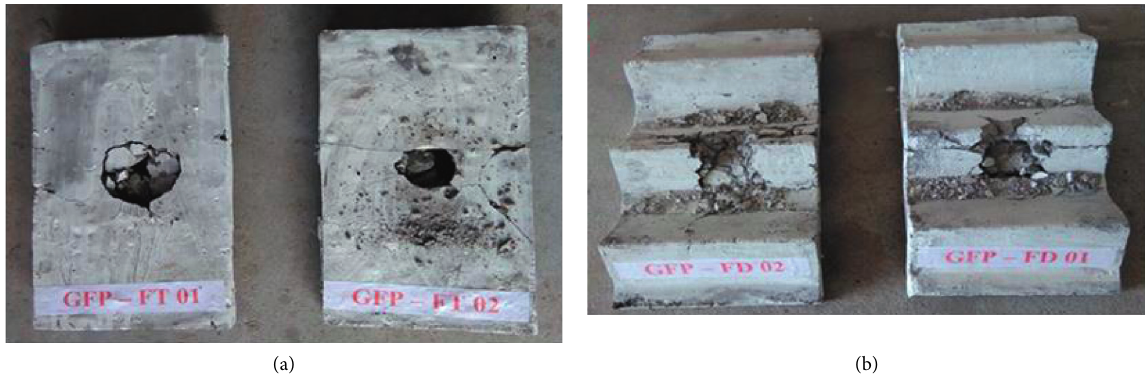
Figure 16: Cracking behavior of GF panels under impact. (a) GF flat panels. (b) GF folded panels.